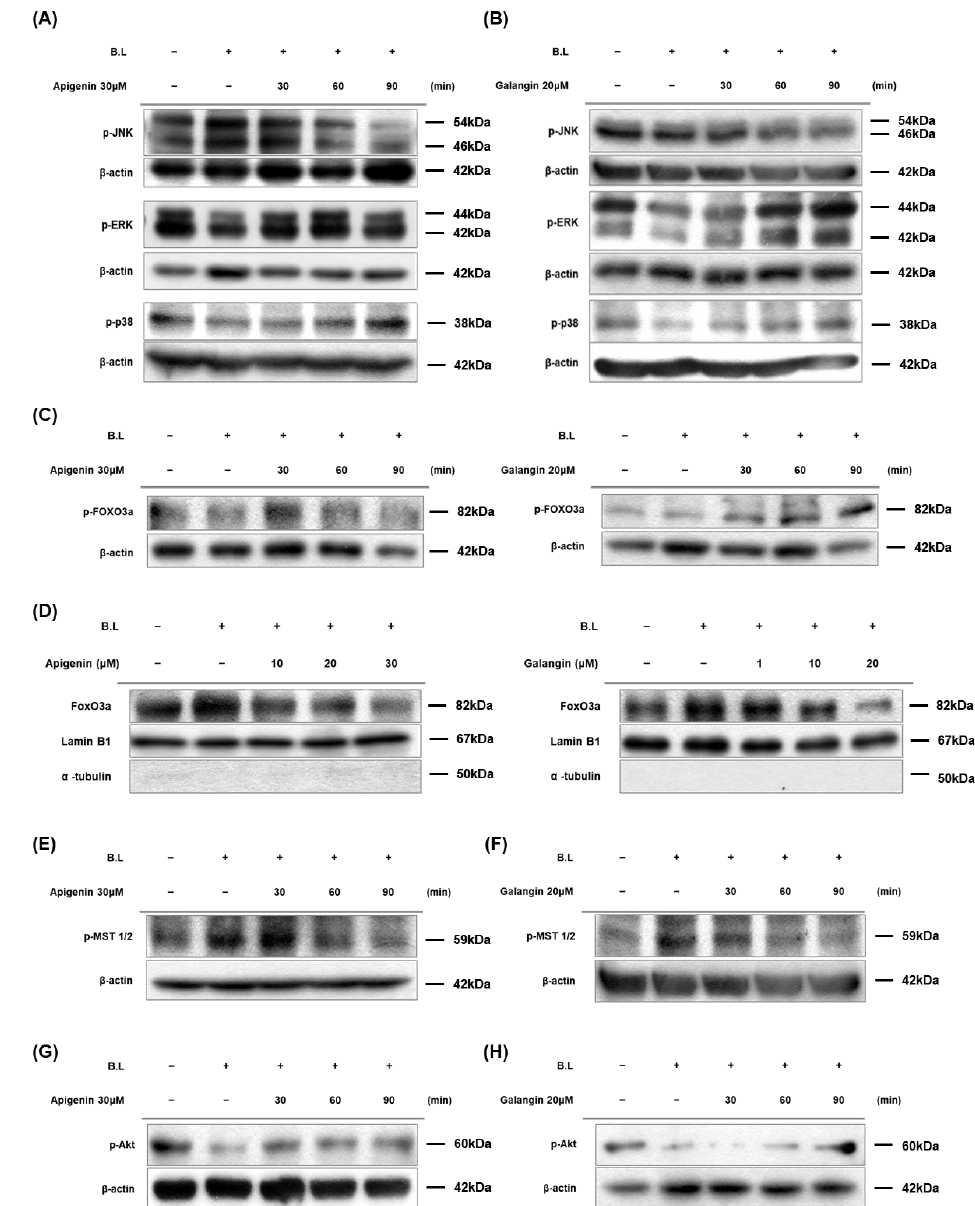
Figure 5. Apigenin and galangin antagonize against blue light by regulating MAPKs and MST-1/2- Akt-FoxO3a signaling. ( A , B ) Apigenin and galangin regulate phosphorylation of MAPKs in blue light-irradiated HaCaT cells. ( A ) Phosphorylation levels of MAPKs were determined by Western blotting at 30-, 60-, and 90- min incubation after, pretreatment with apigenin (30 μM) or galangin (20 μM) for 1 h and subsequent blue light irradiation (30 min, 76 W/m 2 ). The total proteins were ex- tracted from the cells immediately after experimental conditions, and β -actin was used as a loading control. ( C , D ) Apigenin and galangin inhibited FoxO3a nuclear translocation by FoxO3a phosphor- ylation. ( C ) Phosphorylation levels of FoxO3a were determined by Western blotting at 30-, 60-, and 90- min incubation after, pretreatment with apigenin (30 μM) or galangin (20 μM) for 1 h and sub- sequent blue light irradiation (30 min, 76 W/m 2 ). The total proteins were extracted from the cells immediately after experimental conditions, and β -actin was used as a loading control. ( D ) The nu- clear translocation of FoxO3a were determined by Western blotting at 24 h incubation after, 24 h apigenin (10, 20, 30 μM) and galangin (1, 10, 20 μM) pretreatment and 2 -day repetitive blue light irradiation (30 min, 76 W/m 2 ). The nuclear fraction was extracted from the cells immediately after experimental conditions by using NE- PER™ Nuclea r and Cytoplasmic Extraction reagents. Lamin B1 was used as a loading control of nucleus fraction aliquot. ( E , F ) Apigenin and galangin suppress phosphorylation of MST-1/2. ( E ) Phosphorylation levels of MST-1/2 were determined by Western